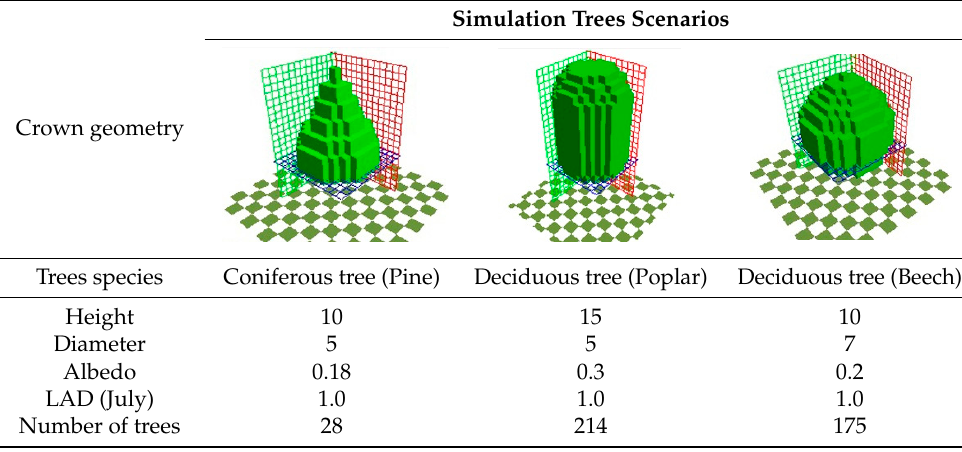
Figure 3. A view of three different trees planted in El ‐ Golu park (trees exemplary dimensions in red).